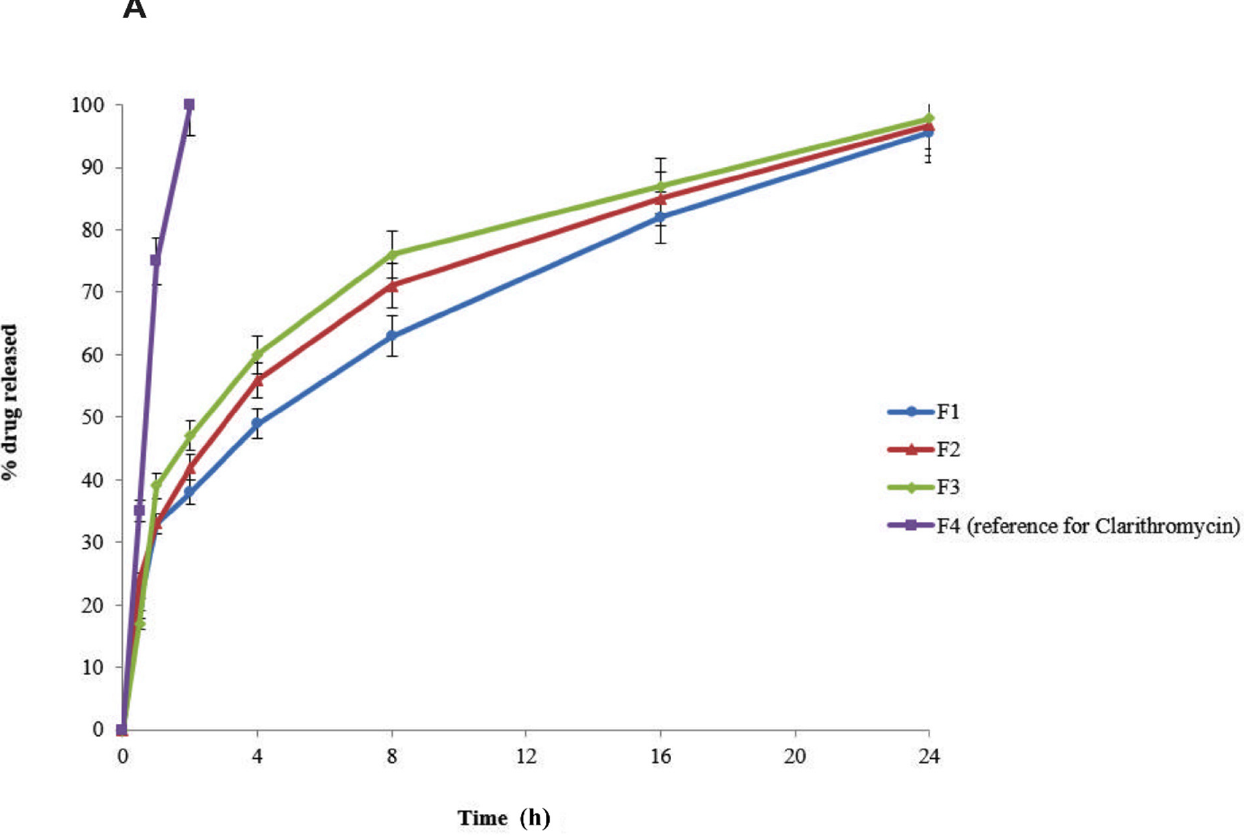
Figure 4. Graphical representation of ( A ) clarithromycin and ( B ) esomeprazole release profiles from controlled-release floating bilayer tablets and reference formulations.